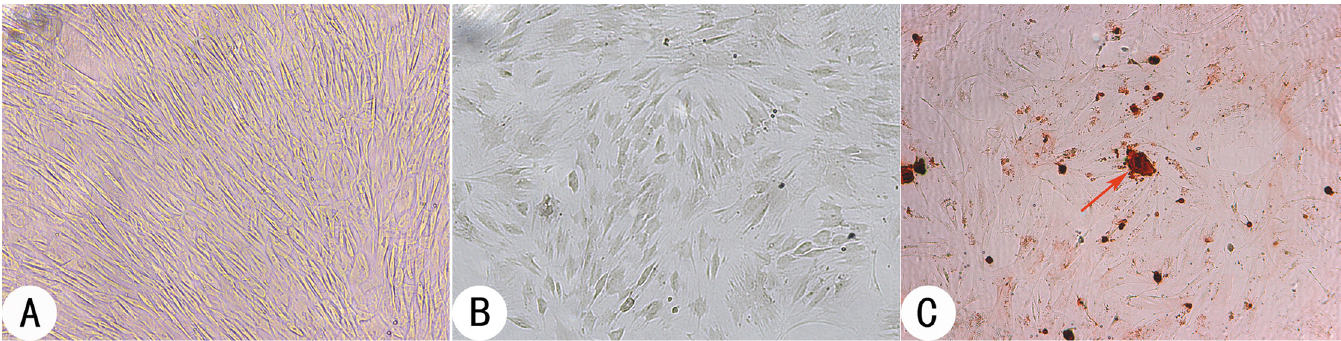
Fig 2. BMSCs and identification of osteogenic differentiation at passage 3. (A) BMSCs cultured in basic medium exhibited typical elongated fibroblast- like morphology. (B) ALP expression was identified by calcium-cobalt staining of black particle deposition in cells after one week of osteogenic induction. (C) Calcified nodules that formed in the extracellular matrix were detected by Alizarin red staining after three weeks of osteogenic induction. The red arrow indicates a calcified nodule (figure magnification